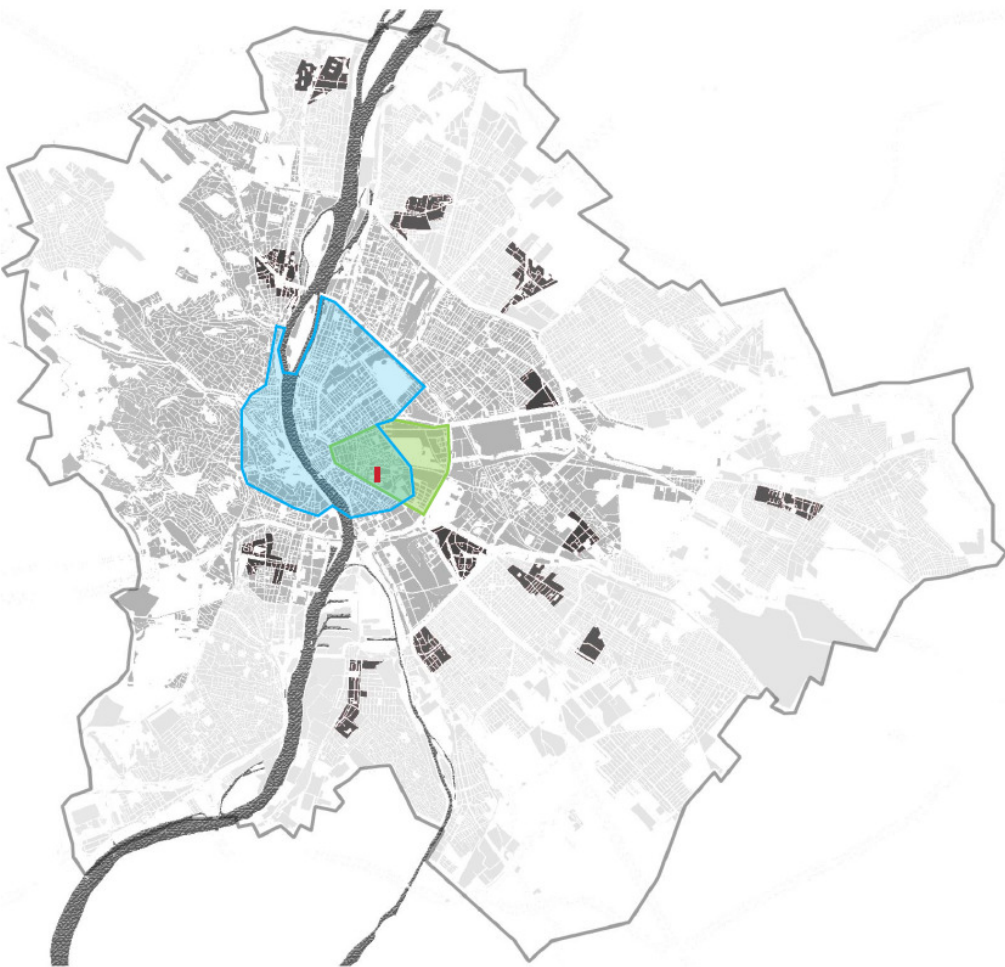
Figure 1. Map of Greater Budapest indicating different developments in the historical periods. Legend: Budapest between 1873 and 1950 (dark grey); suburban zone until 1950 (light grey); historic inner zone (blue); large housing estates with more than 6,000 dwelling units (black); Józsefváros, Budapest’s 8th district (green); Szigony Street, the case study area